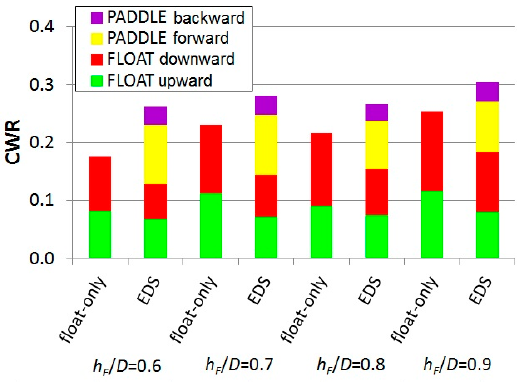
Energies 2018 , 11 , x FOR PEER REVIEW Figure 16. CWR distribution among float and paddle, and motion phases of each body. Wave B.